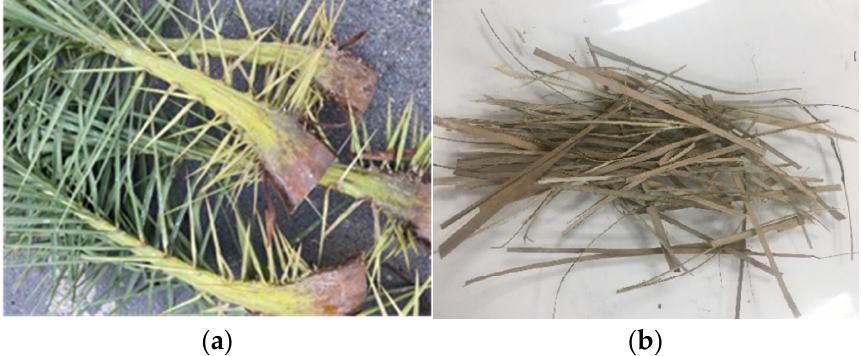
Figure 1. Palm leaves wastes ( a ) fresh palm leaves and ( b ) cut dried palm leaves.